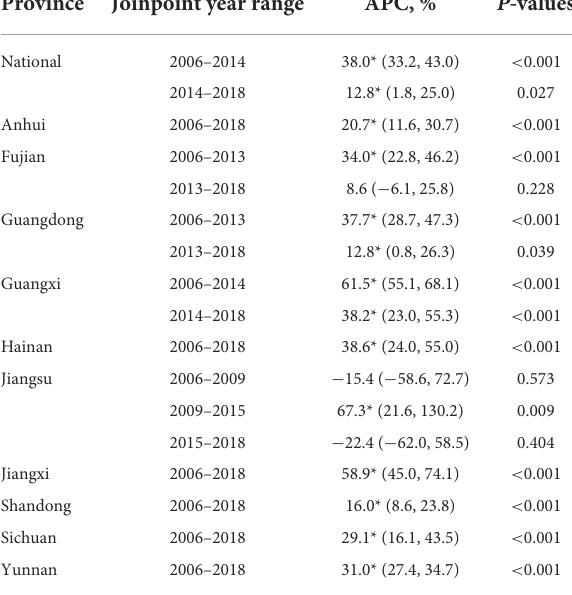
TABLE 1 The annual percentage changes (APC) and the joinpoint year range for scrub typhus in China from 2006 to 2018.